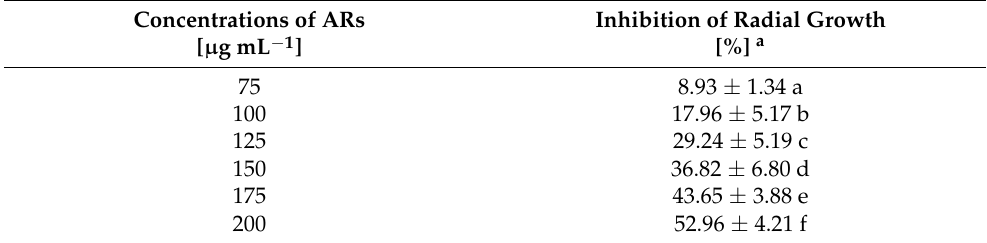
Table 4. The effect of wheat resorcinolic lipids on the radial growth of Rhizoctonia solani F93 mycelium.